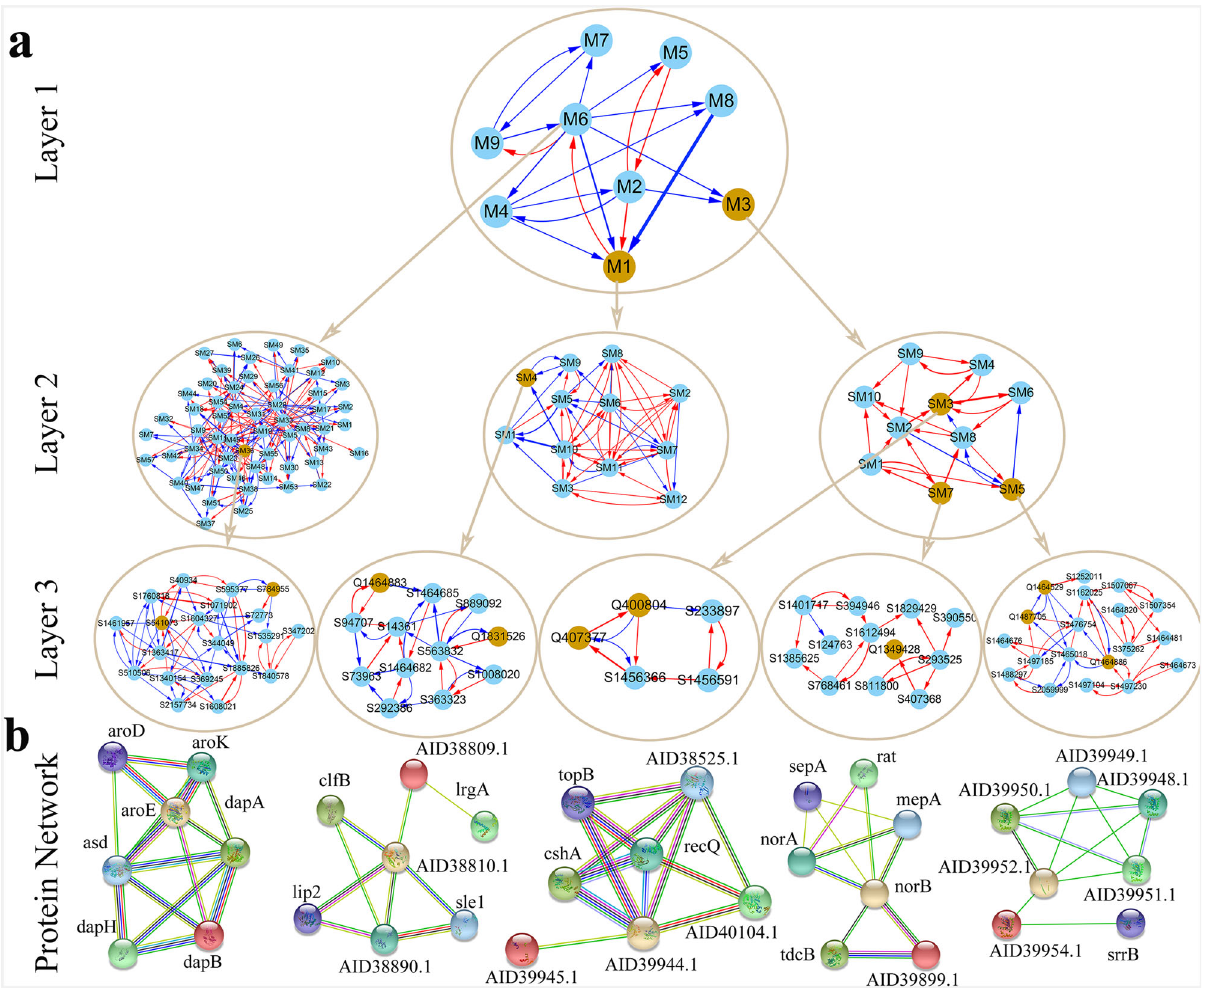
Fig. 6 Multilayer genetic networks reconstructed from a high-dimensional genome-wide SNP data in the biotic GWAS experiment. a On the top is the nine-node network at the fi rst layer among nine modules each presenting a network community. Under the fi rst-layer network are the networks at the second layer reconstructed from submodules of leader module M6 and QTL-containing modules M1 and M3 (highlighted). The second-layer networks go to the third-layer networks at the SNP level from particular submodules. b Interaction networks among proteins (with names indicated) annotated from SNP networks, where the strength of protein interaction is proportional to the thickness of linked